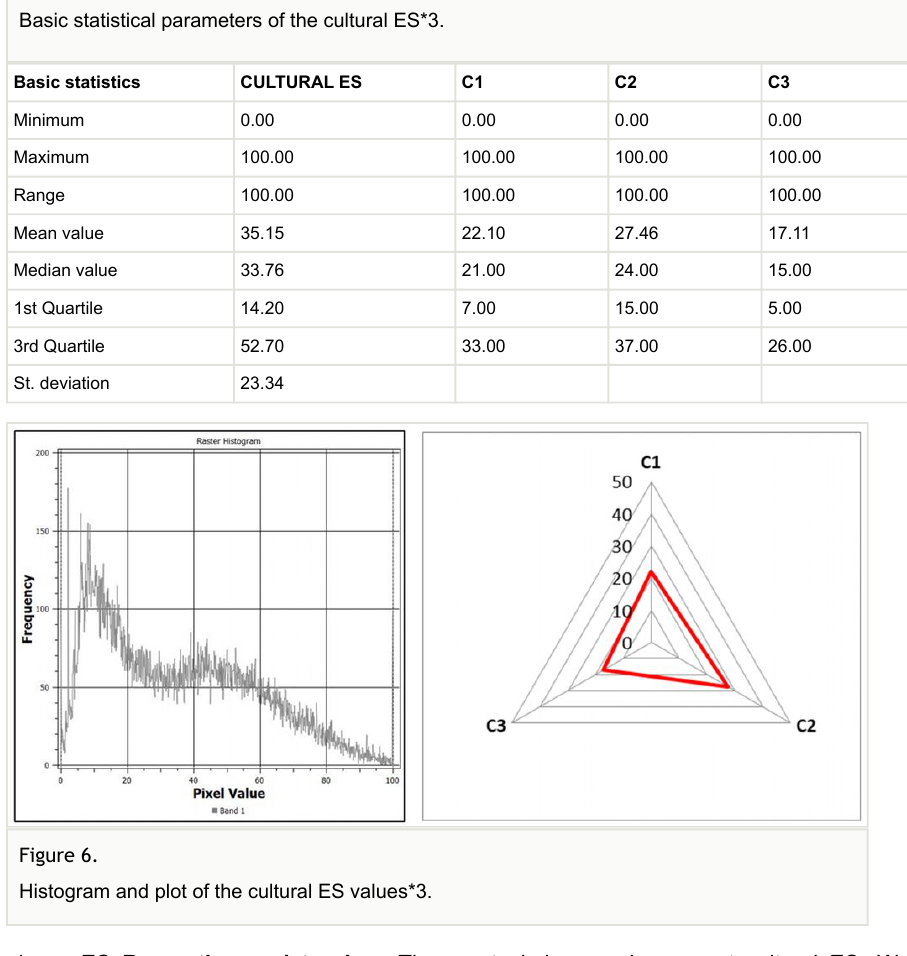
Basic statistical parameters of the cultural ES*3.